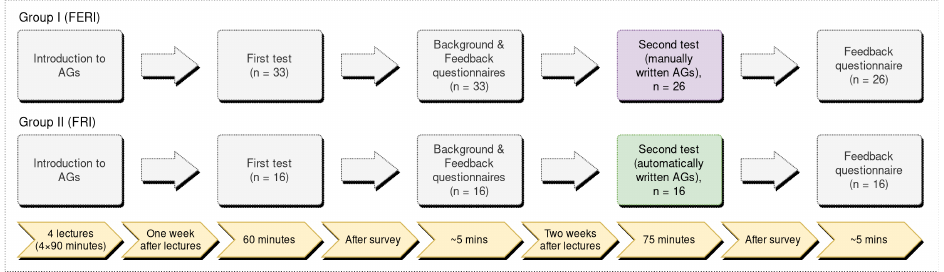
Figure 1. Protocol of the controlled